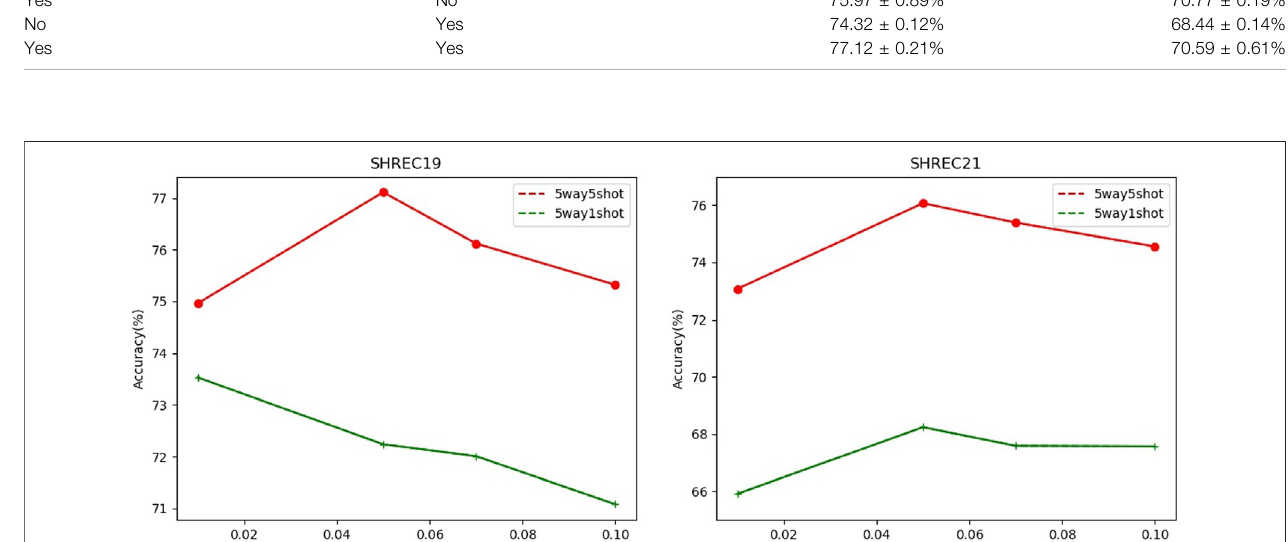
FIGURE 6 | Relationship between classi fi cation accuracy with the weight value λ of the supervised contrastive loss L SCL .